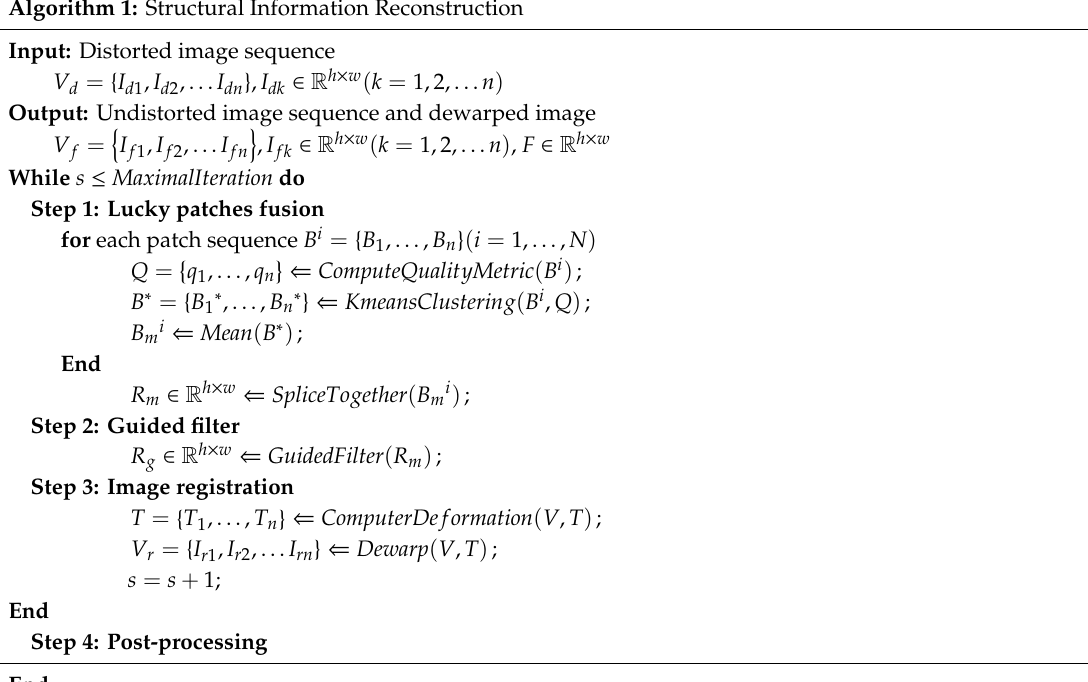
Algorithm 1: Structural Information Reconstruction